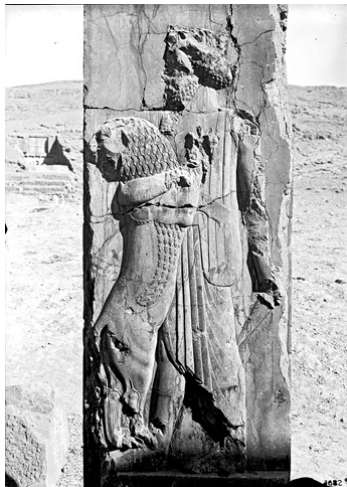
Figure 26. Royal hero strangling a young lion; relief scene; Tachara, Persepolis, Persia (mod. Iran); Achaemenid, ca. 522–465 BCE [photography by Ernst Herzfeld, ca. 1923–1928; image courtesy of the Freer and Sackler Archives, Smithsonian, Washington, D.C., inv. no. A.6 04.GN.1682].